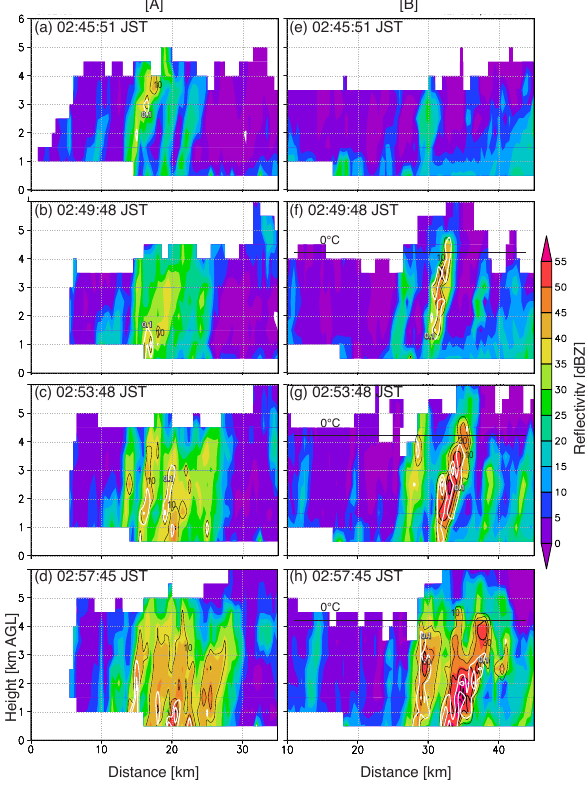
Figure A2. Distance-height cross-section of rainfall rate and ice fraction superimposed over the attenuation- Fig. A2. Distance–height cross section of rainfall rate and ice (cid:70)(cid:82)(cid:85)(cid:85)(cid:72)(cid:70)(cid:87)(cid:72)(cid:71)(cid:3)(cid:85)(cid:72)(cid:193)(cid:72)(cid:70)(cid:87)(cid:76)(cid:89)(cid:76)(cid:87)(cid:92)(cid:3)(cid:82)(cid:73)(cid:3)(cid:36)(cid:3)(cid:11)(cid:68)(cid:16)(cid:71)(cid:12)(cid:3)(cid:68)(cid:81)(cid:71)(cid:3)(cid:37)(cid:3)(cid:11)(cid:72)(cid:16)(cid:75)(cid:12)(cid:3)(cid:68)(cid:79)(cid:82)(cid:81)(cid:74)(cid:3)(cid:87)(cid:75)(cid:72)(cid:3)(cid:68)(cid:81)(cid:68)(cid:79)(cid:92)(cid:87)(cid:76)(cid:70)(cid:3)(cid:68)(cid:85)(cid:72)(cid:68)(cid:3)(cid:76)(cid:81)(cid:3)(cid:41)(cid:76)(cid:74)(cid:17)(cid:3)(cid:27)(cid:17)(cid:3)(cid:37)(cid:79)(cid:68)(cid:70)(cid:78)(cid:3)(cid:70)(cid:82)(cid:81)(cid:87)(cid:82)(cid:88)(cid:85)(cid:86)(cid:3)(cid:76)(cid:81)(cid:71)(cid:76)(cid:70)(cid:68)(cid:87)(cid:72)(cid:3)(cid:72)(cid:86)(cid:87)(cid:76)(cid:80)(cid:68)(cid:87)(cid:72)(cid:71)(cid:3) (cid:85)(cid:68)(cid:76)(cid:81)(cid:73)(cid:68)(cid:79)(cid:79)(cid:3)(cid:85)(cid:68)(cid:87)(cid:72)(cid:86)(cid:3)(cid:73)(cid:85)(cid:82)(cid:80)(cid:3)(cid:68)(cid:3)(cid:61)(cid:16)(cid:53)(cid:3)(cid:85)(cid:72)(cid:79)(cid:68)(cid:87)(cid:76)(cid:82)(cid:81)(cid:3)(cid:82)(cid:73)(cid:3)(cid:20)(cid:19)(cid:15)(cid:3)(cid:22)(cid:19)(cid:15)(cid:3)(cid:25)(cid:19)(cid:15)(cid:3)(cid:20)(cid:21)(cid:19)(cid:3)(cid:68)(cid:81)(cid:71)(cid:3)(cid:20)(cid:27)(cid:19)(cid:3)(cid:80)(cid:80)(cid:3)(cid:75) -1 , and white contours depict ice fraction from 0.1 fraction superimposed over the attenuation-corrected reflectivity of with a contour interval of 0.1. The observation time is shown in the upper-left of each image. A (a–d) and B (e–h) along the analytic area in Fig. 8. Black con- tours indicate estimated rainfall rates from a Z – R relation of 10, 30, 60, 120 and 180mmh − 1 , and white contours depict ice frac- tion from 0.1 with a contour interval of 0.1. The observation time is shown in the upper-left of each image.